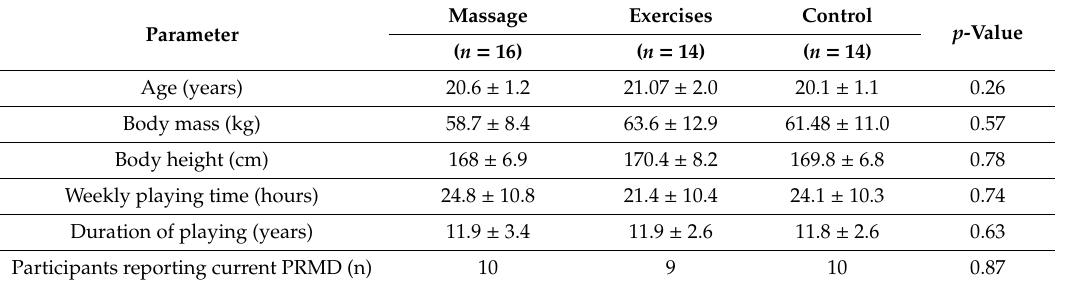
Table 1. Participants characteristics (Mean,